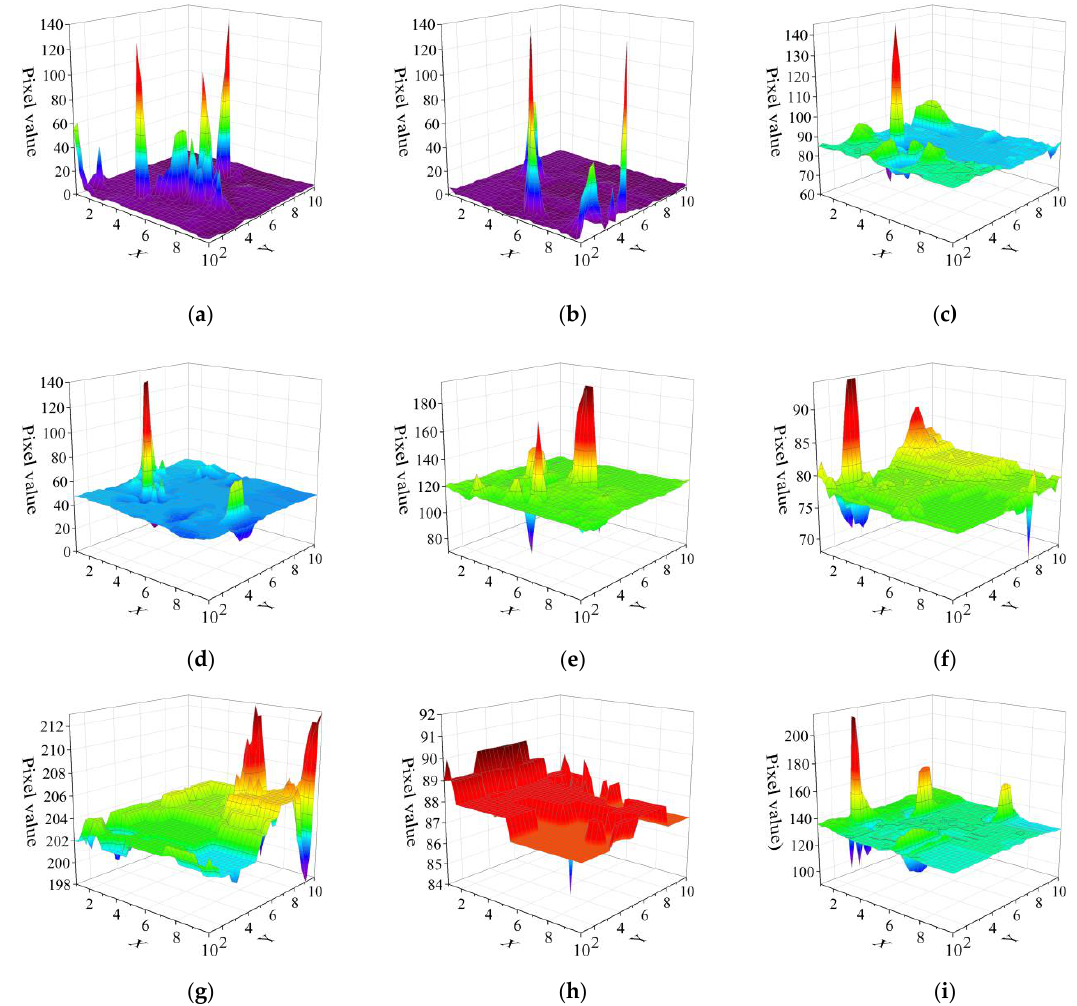
Figure 3. Radiation response events in different color areas. ( a – i ) is the response signal diagram of the corresponding area in Figure 2.